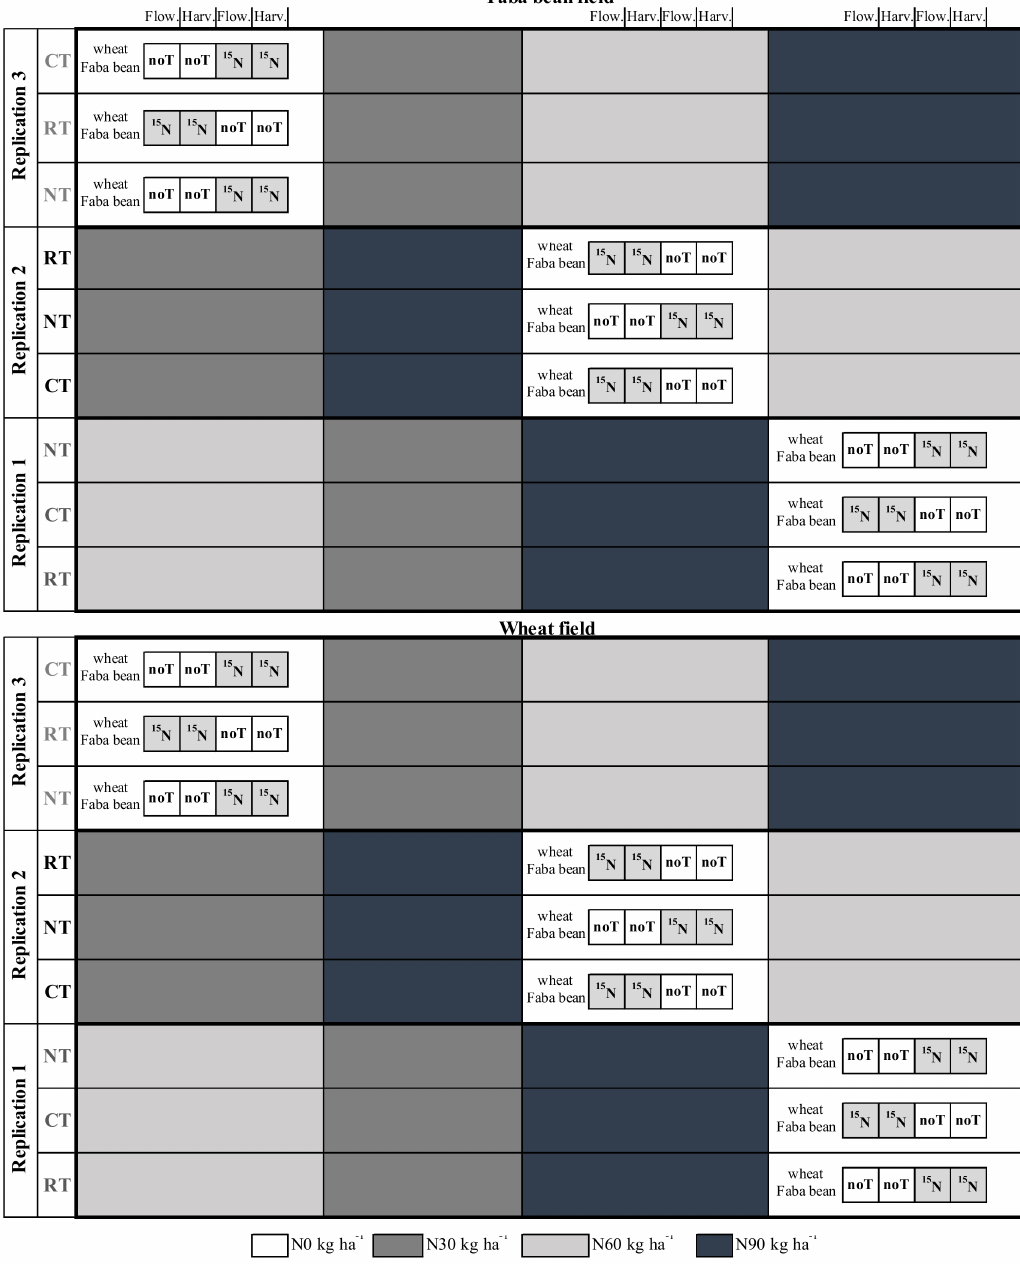
Figure 1. Schematic overview of N 2 fixation experimental design and microplot positions within the long-term wheat–faba bean rotation experiment. The microplots were organized within the main rotation experimental plot, which received 0 kg ha − 1 of nitrogen during wheat cultivation. The size of the main plot was 1 ha, while the microplots were 1 m 2 ; nitrogen at levels of 0, 30, 60, and 90 was applied to the subplot of the main rotation experiment during wheat cultivation. CT, RT, and NT stand for conventional tillage, reduced tillage, and no tillage, respectively; noT: no treated microplots; 15 N: 15N-enriched microplots. Flow. and Harv. indicate the corresponding microplots that were harvested at flowering and physiological maturity,